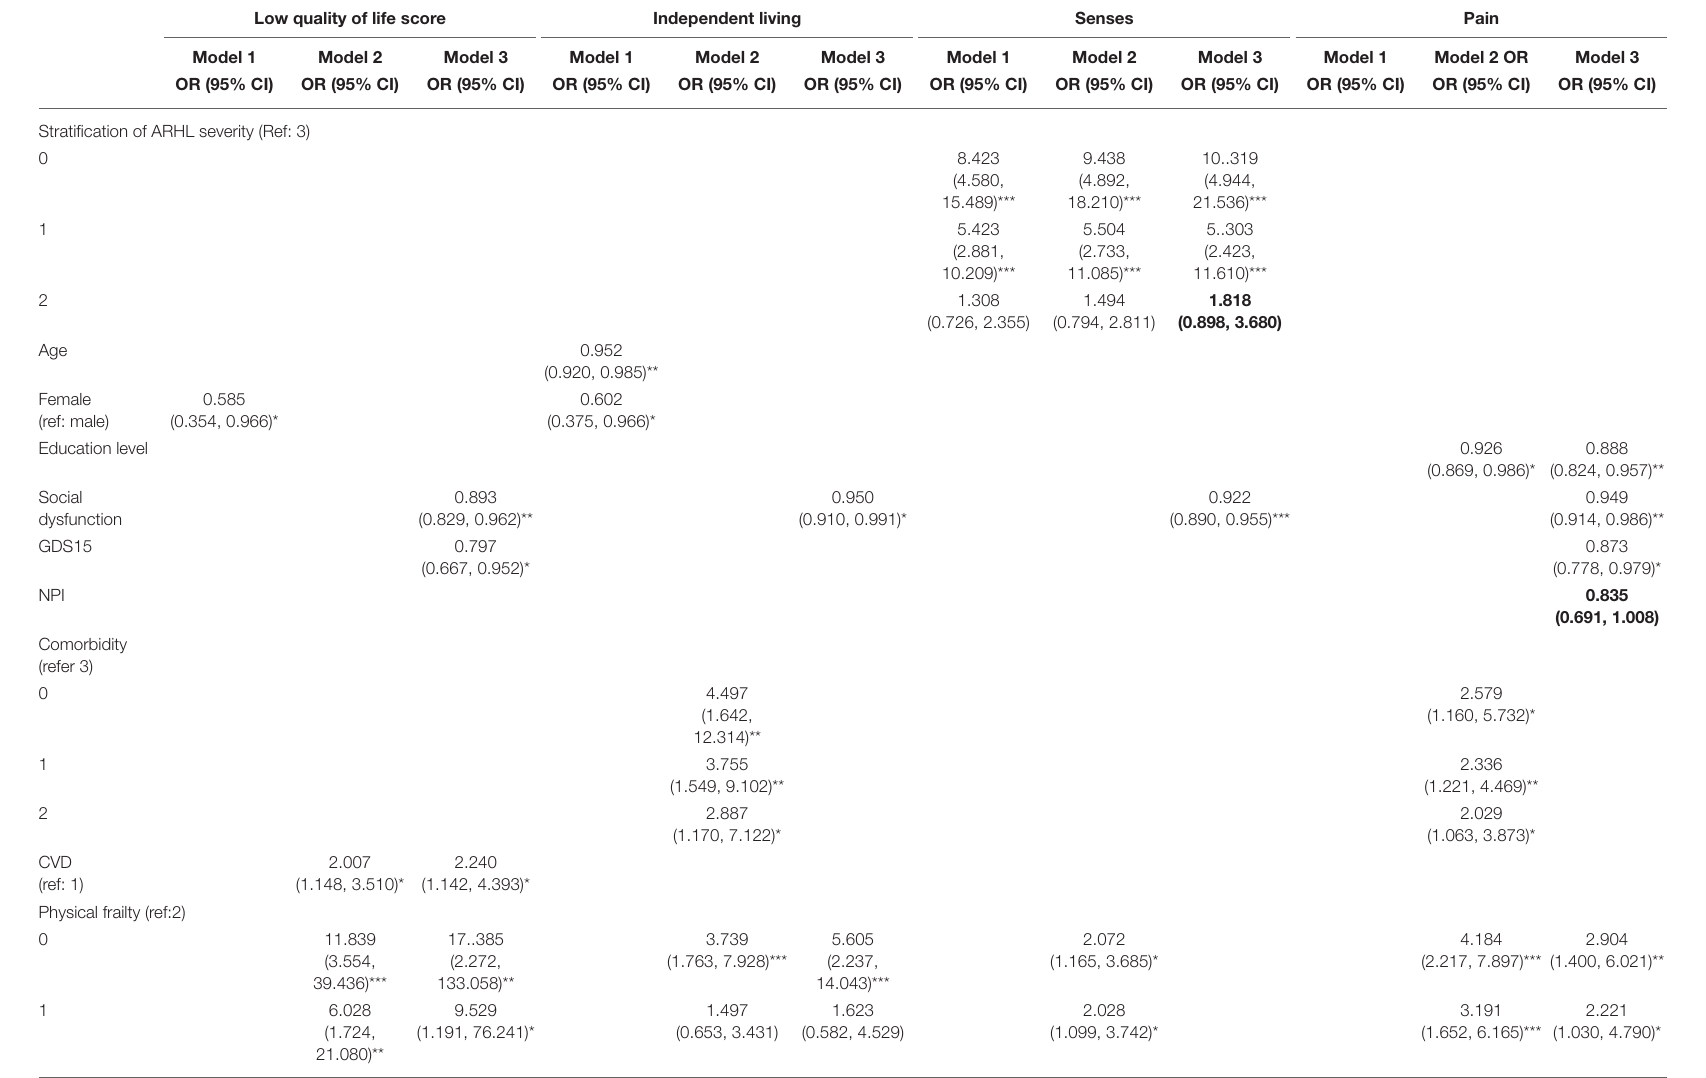
OR = odds ratios; CI = confidence intervals; ARHL, age-related hearing loss; CVD, cardiovascular disease; GDS, the Geriatric Depression Scale; NPI, self-report Neuropsychiatric Inventory Questionnaire. Model 1 is adjusted for age, gender, education, and social dysfunction. Model 2 is adjusted for covariates in model 1 and health-related factors, including self-reported smoking, alcohol intake, BMI, chronic comorbidities, chronic diseases, physical frailty, cognition based on normative z-scores of neuropsychological test battery. Model 3 is adjusted for covariates in model 2 and GDS, NPI and social dysfunction. HL 0 = Normal hearing; HL 1 = subclinical hearing loss; HL 2 = mild HL; and HL 3 = moderate or severe HL. CVD 0 = without CVD; CVD 1 = with CVD. Physical frailty 0 = robust; physical frailty 1 = pre-physical frailty; and physical frailty 2 = physical frailty. * p < 0.05; ** p < 0.01; and *** p < 0.001; bold values denote marginally statistical